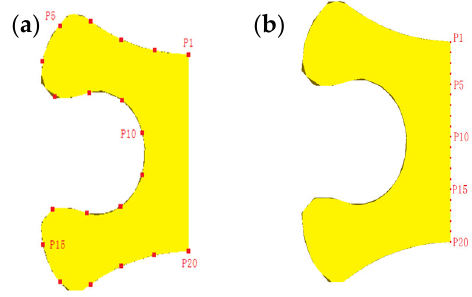
Figure 10. Point position ( a ) edge; ( b ) center.